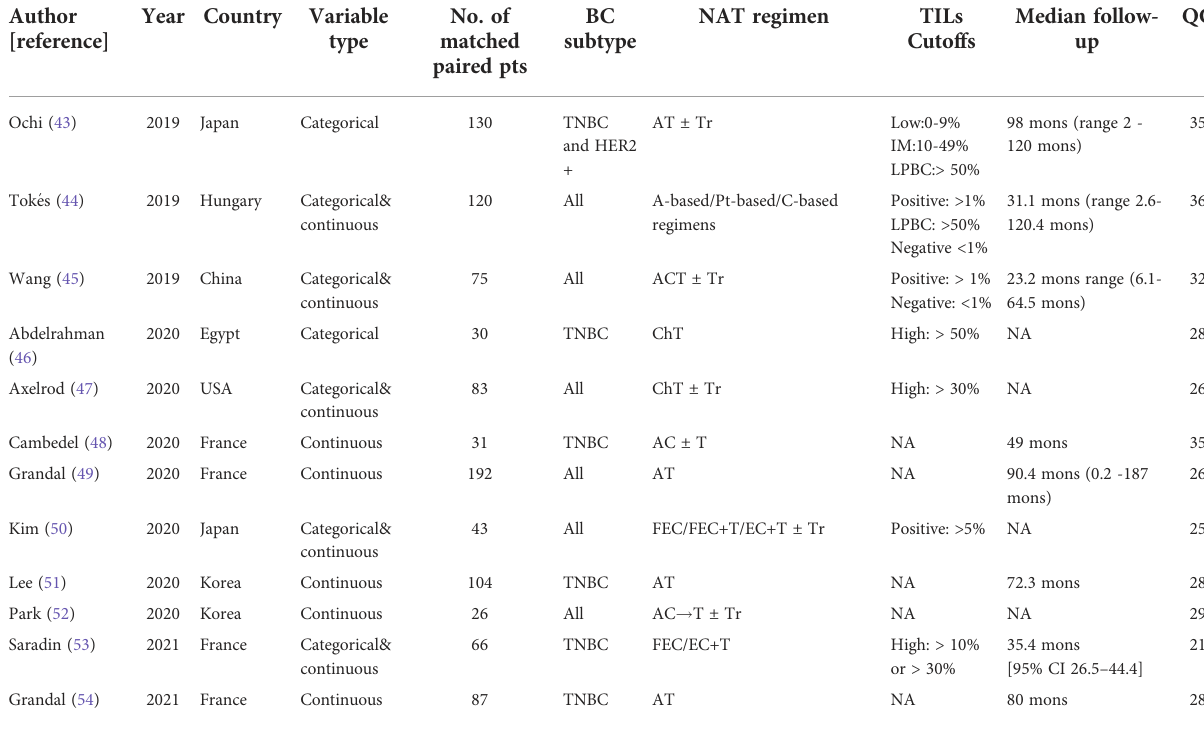
pooled OR [95% CI] = 1.60 [95% CI: 1.12-2.30]; HER2- positive: pooled OR [95% CI] =1.88 [0.87-4.08); TNBC: pooled OR [95% CI] =1.05 [0.41-2.68]. Difference in pooled rates of